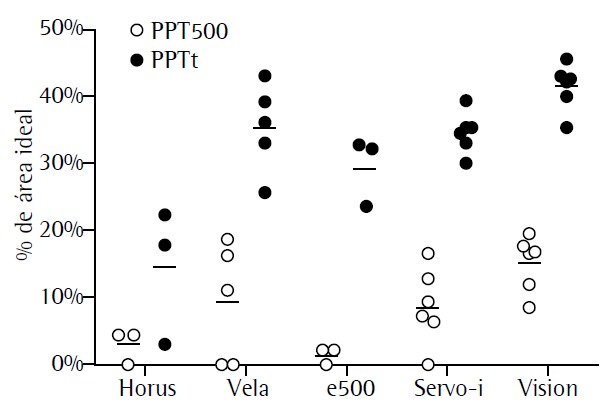
 Características de pressurização de cinco dos ventiladores testados,
demonstradas pelo produto da pressão e tempo inspiratórios a 500 ms (PPT500;
círculos vazados) e a 1 s (PPTt; círculos preenchidos), em porcentagem de
área ideal. Os traços horizontais indicam as médias de todas as medidas
(pressão expiratória final positiva de 5 e 10 cmH2O vs. pressão de suporte
de 5, 10 e 15 cmH2O) disponíveis para os ventiladores.